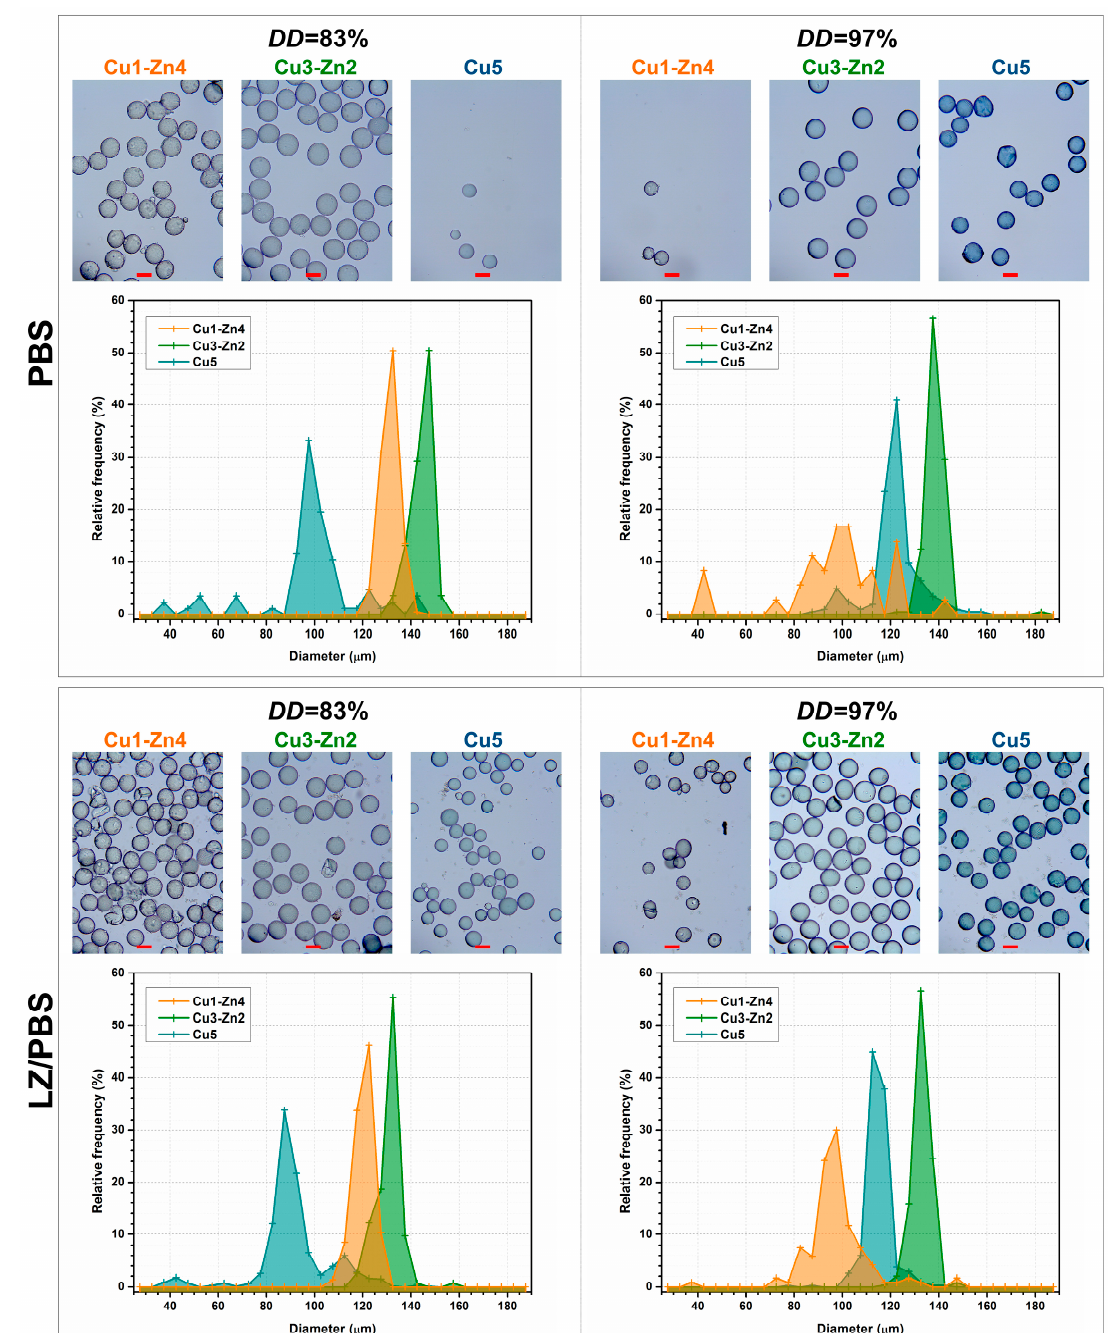
Figure 5. Microgel size distribution and optical micrographs of bimetallic chitosan microgels of chitosan with different deacetylation degrees (83 and 97%) obtained in phosphate-buffered saline solution (PBS, pH 7.4) after 24 h and after 4 weeks of incubation in lysozyme/PBS at 37 °C. The scale bar is 100 µm.